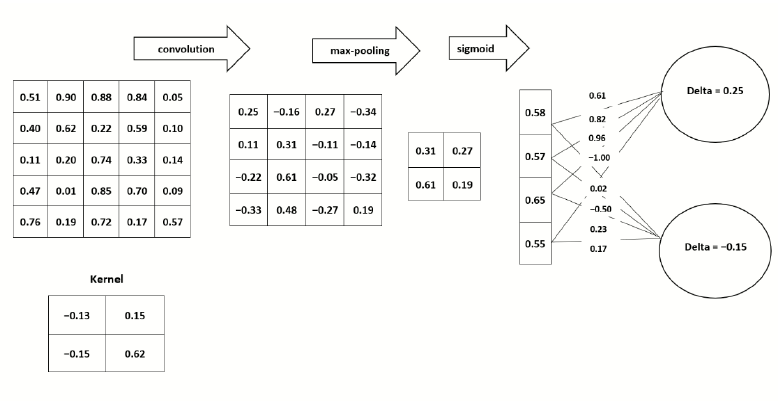
Figure 4. A CNN architecture with a normalized (5 × 5) input image convolved with a normalized fil- ter (2 × 2 kernel) showing the three most common operations (convolution, pooling, and weights ma- trix multiplication operations) in a CNN. This low-level abstraction shows the internal computation performed on the network parameters (i.e., the input tensor (5 × 5 image), weights, and